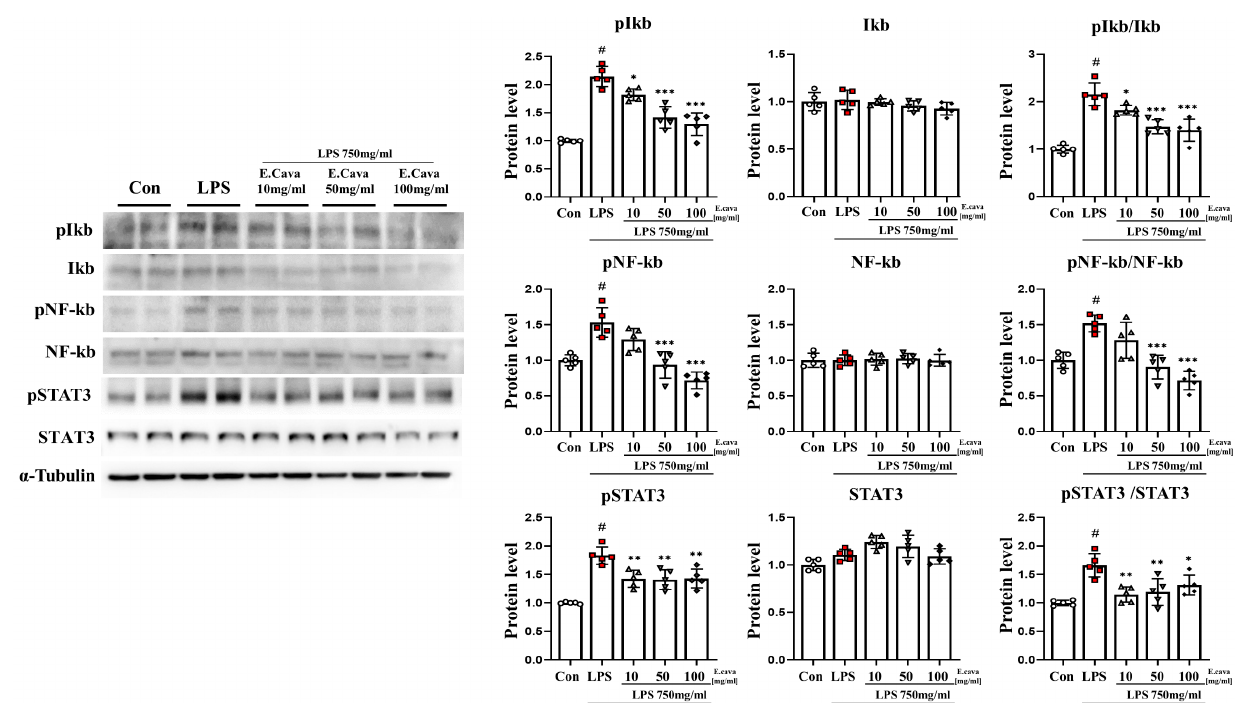
Figure 3. E. cava reduces inflammation-regulated markers in the hippocampus. Western blot analysis and quantification of inflammation-regulated related genes were evaluated in the hippocampus of each group of male mice. Alpha-Tubulin was used for internal control. The points on the graph are represented by different shapes, with a white circle indicating the control group, a red square indicating the LPS group, a triangle representing the LPS + E. cava 10 mg/kg group, an inverted triangle indicating the LPS + E. cava 50 mg/kg group, and a rhombus representing the LPS + E. cava 100 mg/kg group. The differences between means were obtained through one-way ANOVA, and then a Tukey post-analysis. The values represent means ± S.D. # p < 0.001 vs. control group